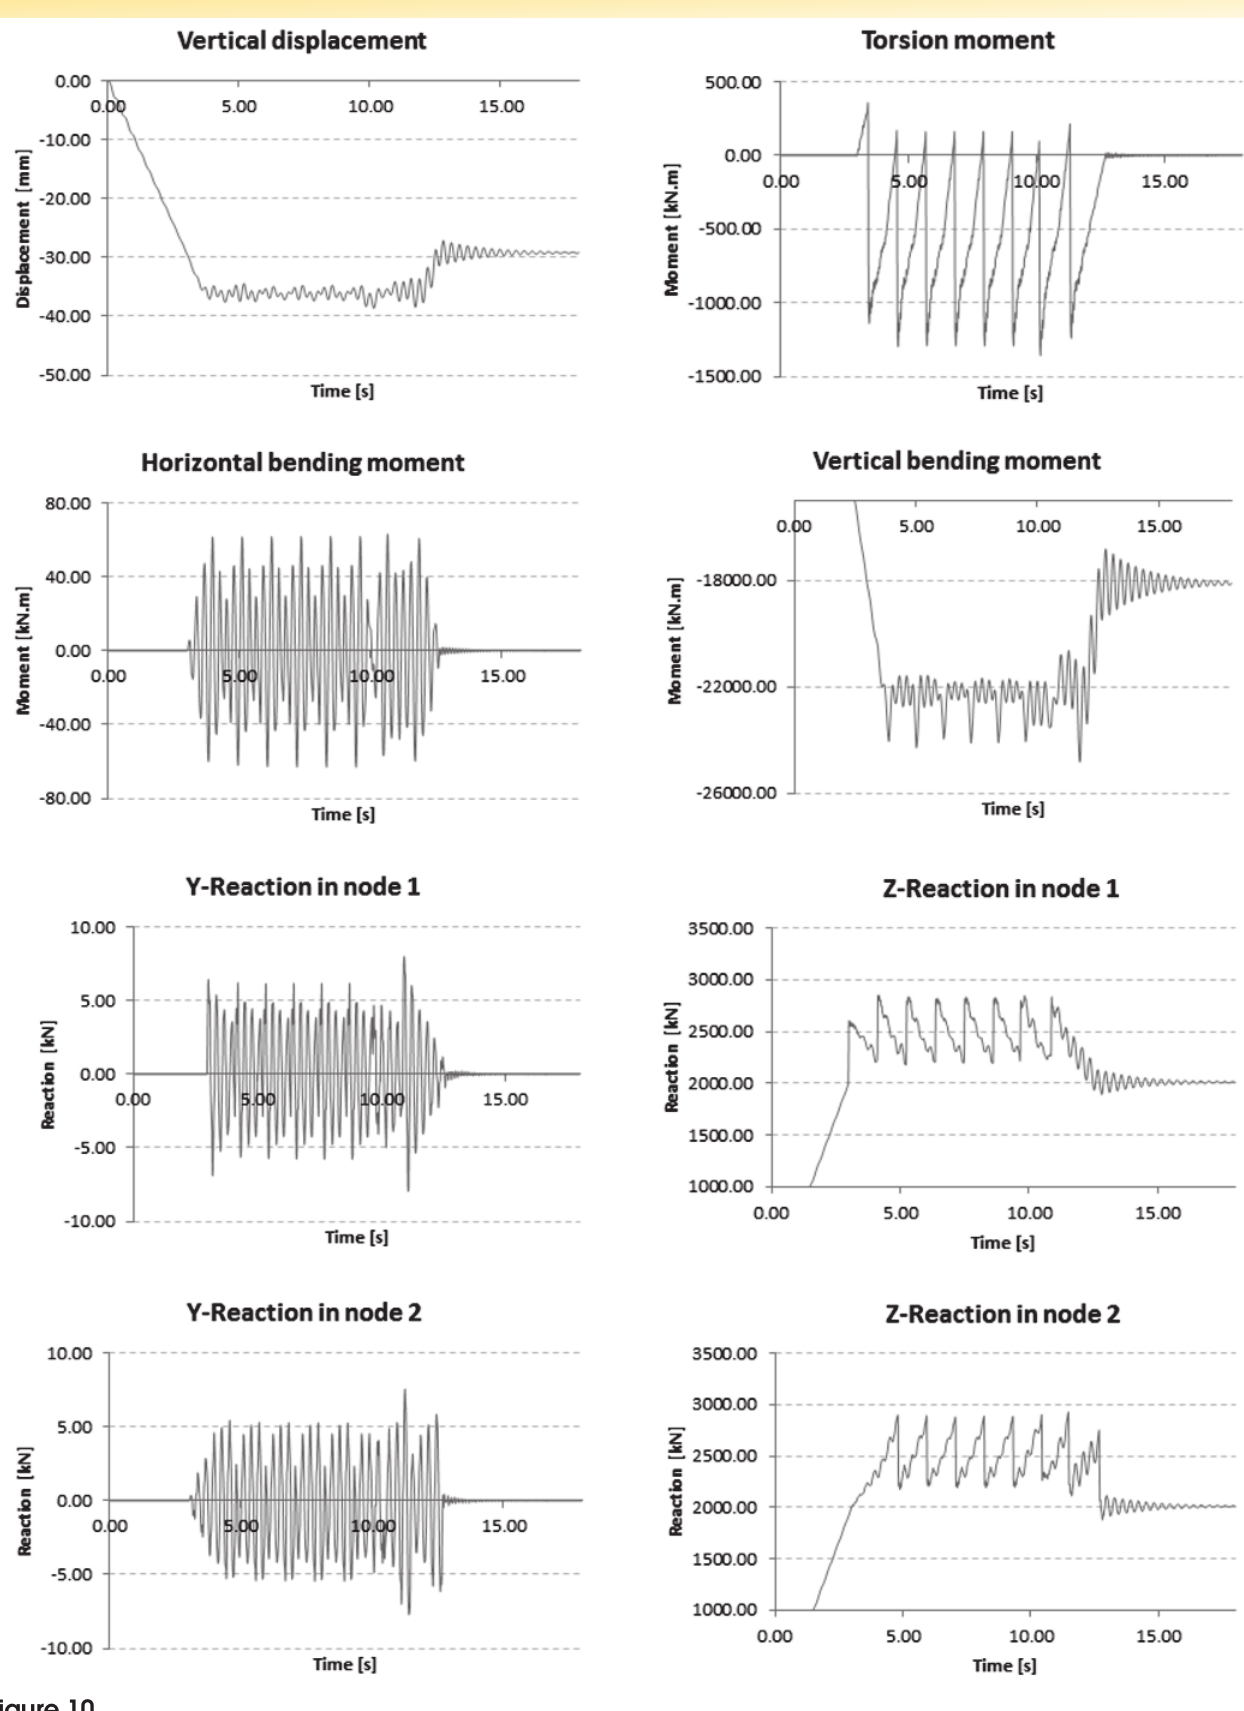
Results – dynamics analysis for